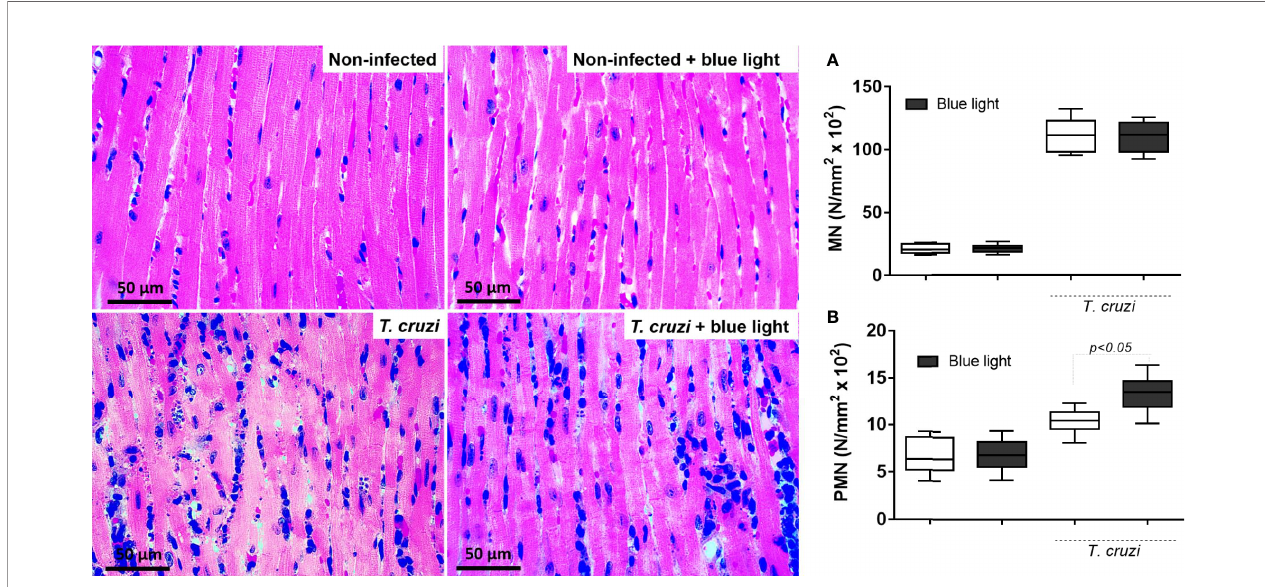
FIGURE 7 | Photomicrography of cardiac tissue and analysis of the in fl ammatory in fi ltration. Cardiac tissue from non-infected and T. cruzi -infected animals were analyzed under conventional light and blue light phototherapy. In fl ammatory cells and loss of tissue integrity are evidenced in those images related to parasite infection. Cardiac tissue from animals under conventional and blue light phototherapy was analyzed and mononuclear cells (A) polymorphonuclear cells (B) quanti fi ed. p<0.05 means differences between infected groups under blue light and conventional